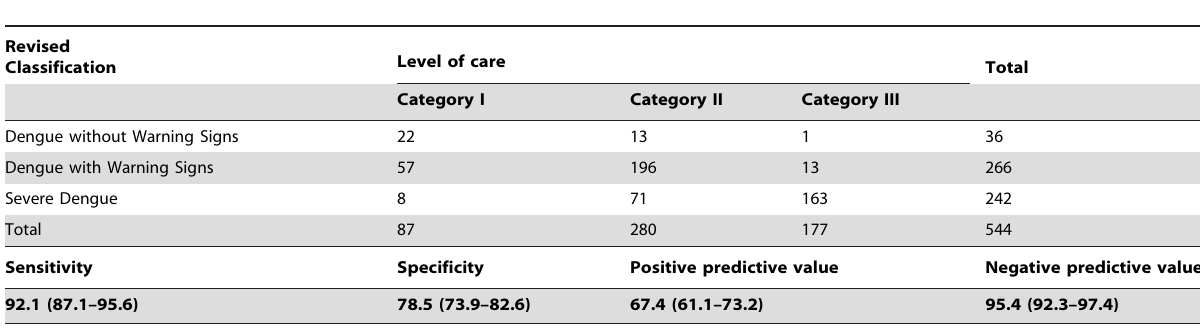
Table 5. Revised WHO classification of severity versus level of care,